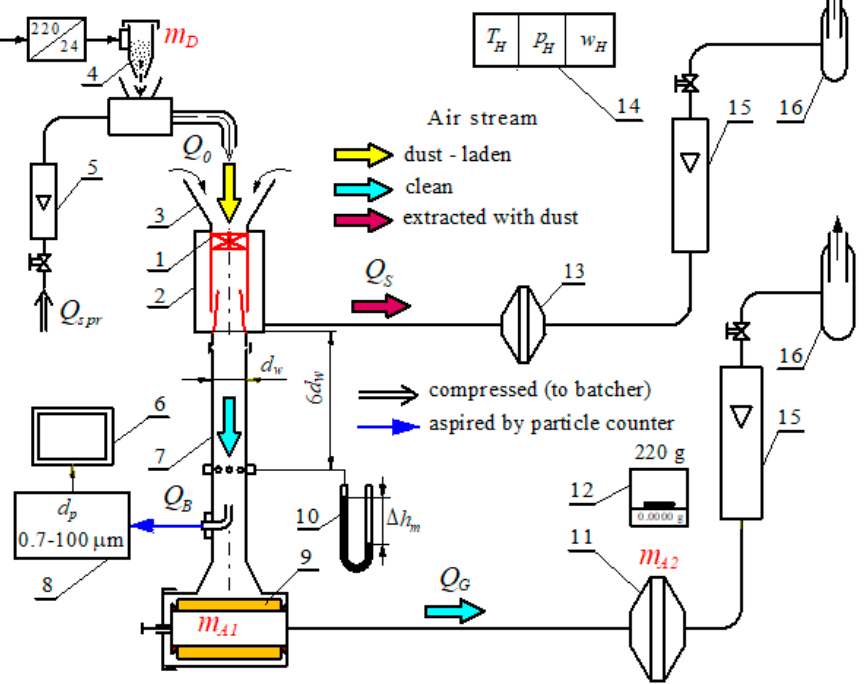
Figure 10. The functional diagram of the test stand for axial-flow cyclones: 1—tested axial flow cyclone, 2—dust collector, 3—dust chamber, 4—dust container, 5—compressed air measuring rotameter, 6—computation unit, 7—outlet pipe from cyclone, 8—particle counter, 9—measuring absolute filter A1 of main stream, 10—U-tube liquid manometer, 11—measuring absolute filter A2 of the main stream, 12—analytical balance, 13—filter securing suction flow rotameter, 14—set for measuring humidity, ambient air temperature, and pressure, 15—rotameters for measurement of main air flow Q G and suction Q S , 16—fans forcing air flow.